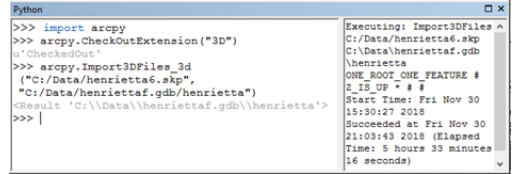
Figure 6 : python script to import SketchUp file into ArcGIS